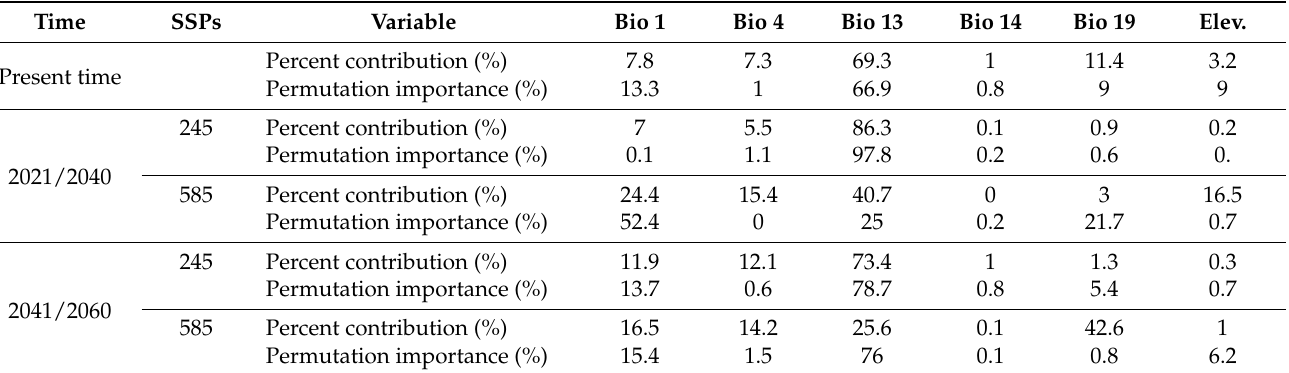
Table 2. Percent contribution and permutation importance of environmental variables used to predict the MaxEnt model of Salvia ceratophylloides Ard. [SSPs- future scenarios (see text) Bio 1, Bio 4, Bio 13, Bio 14, and Bio 19. Elev (see Table 1)].